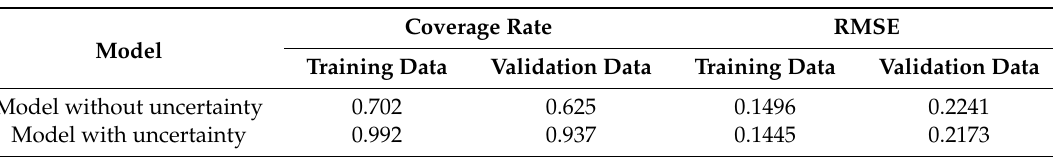
Figure 2. Predicted versus observed results for the training data. The first row shows the mean and 95% confidence interval (CI) of the predicted versus the real observed fuel consumptions, with ( left ) and without ( right ) considering input uncertainty. The second row shows the absolute error between the predicted mean fuel consumption and the real observation (blue line), as well as the predicted error (half of the 95% CI, orange line), both with ( left ) and without ( right ) considering input uncertainty. Table 3. Coverage rate that the 95% confidence interval (CI) covers the observed value and the root mean square error (RMSE) for di ff erent